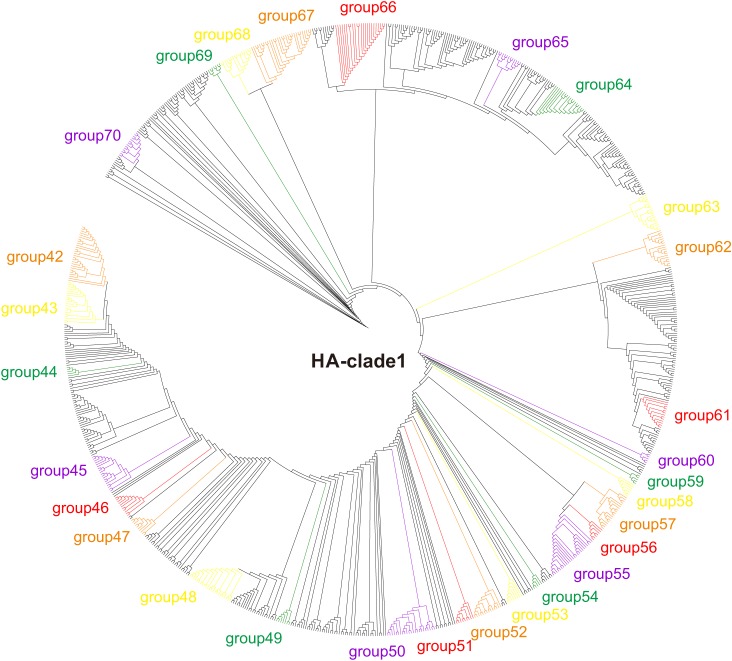
Phylogenetic tree of H5 clade 1 of H5Nx viruses. Maximum likelihood tree of H5Nx viral sequences generated using RAxML v.8.0.14 with the best fitting sequence evolutionary model identified by ModelTest.